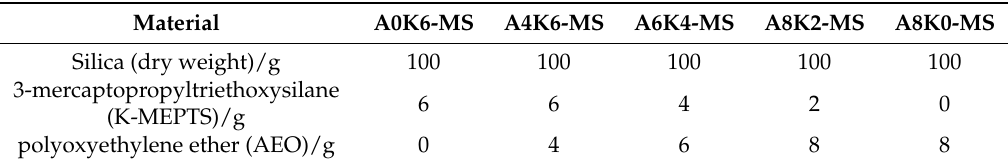
Table 1. Formulation of modified silica and its label.